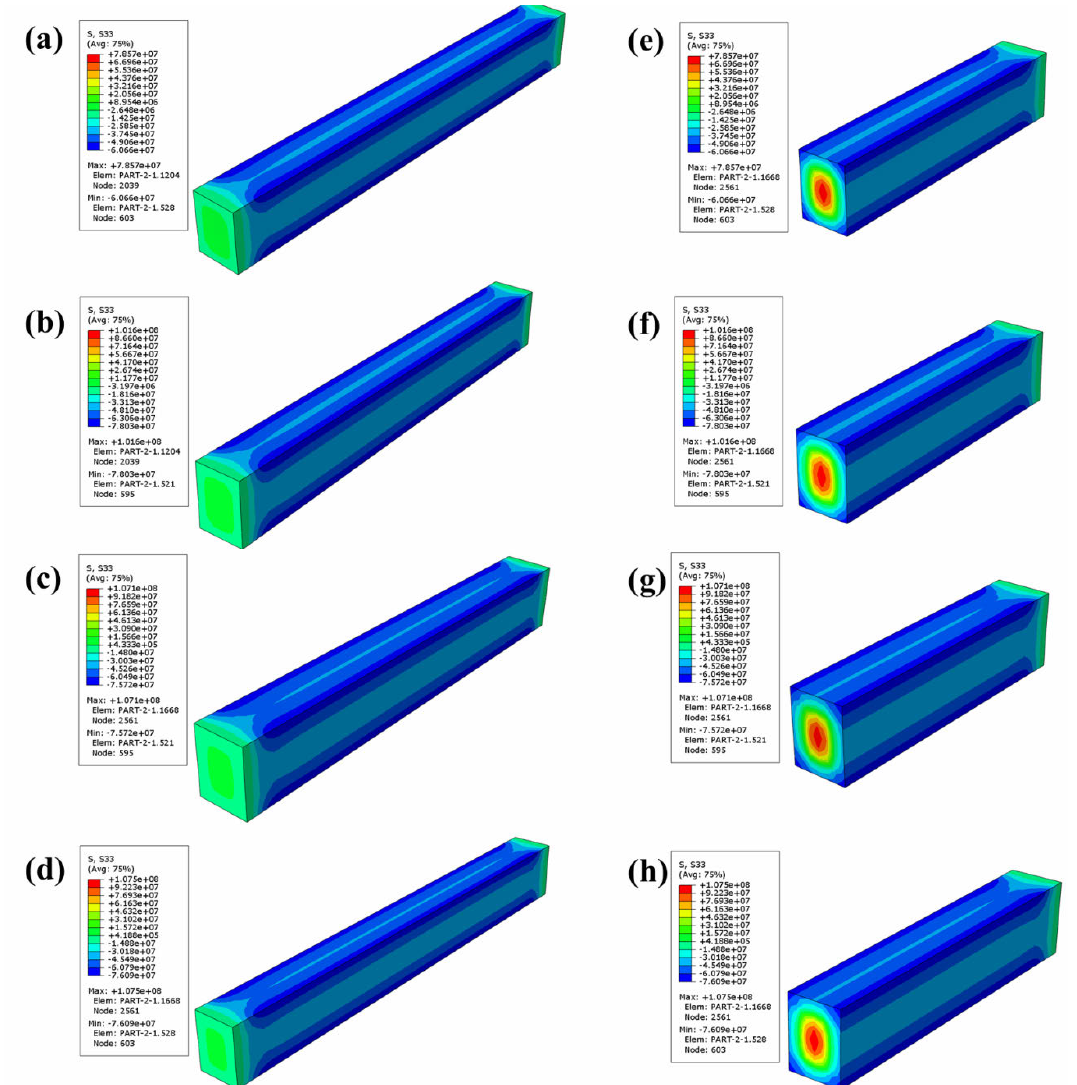
Fig. 5 Thermal stress distribution after rapid heating thermal shock testing: (a, e) T  = 400 ℃ , (b, f) T  = 800 ℃ , (c, g) T  = 1200 ℃ , and (d, h) T  = 1600 ℃